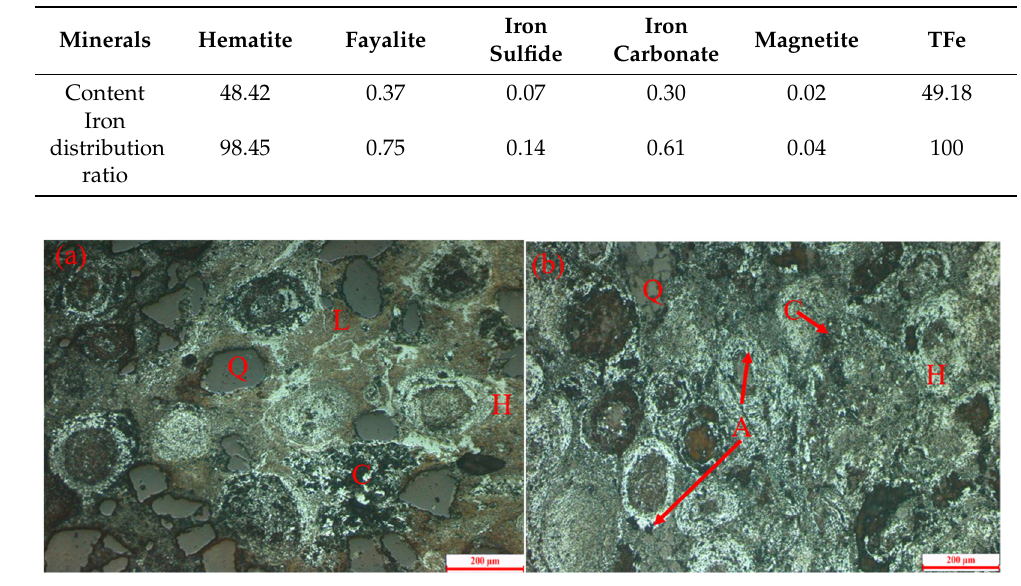
Figure 2. Microstructure of HPOHO (L: Goethite, H: Hematite, Q: Quartz, C: Chamosite, A: Apatite). ( a ) and ( b ) are the microstructure of HPOHO observed under a microscope